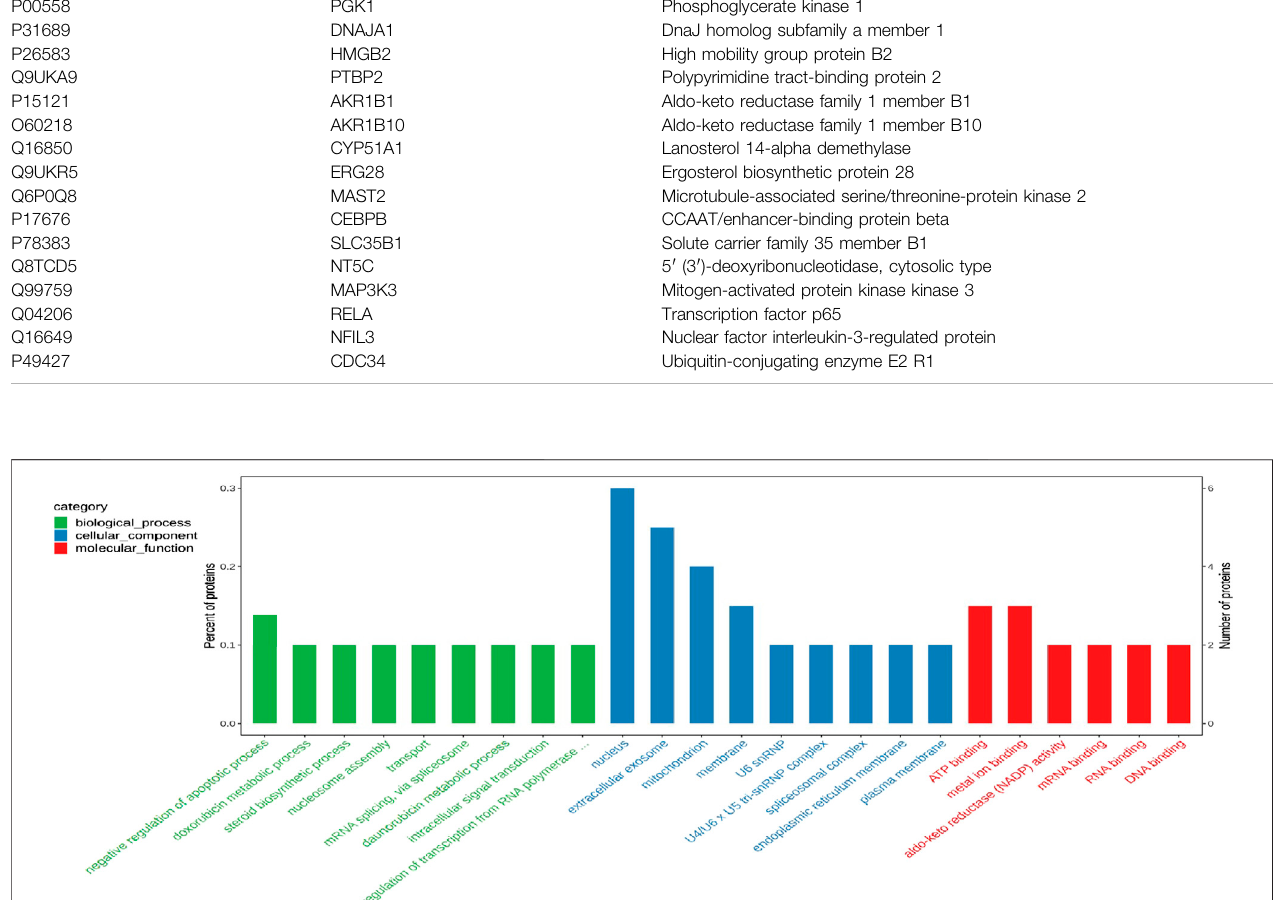
Frontiers in Pharmacology |